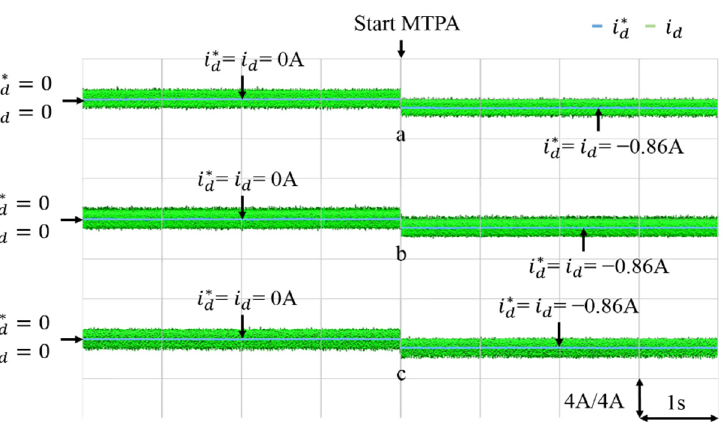
Figure 11. Variations of connected weights of the PID neural network of q -axis current-loop from no load torque to 4.75 Nm load torque at 1000 rpm.